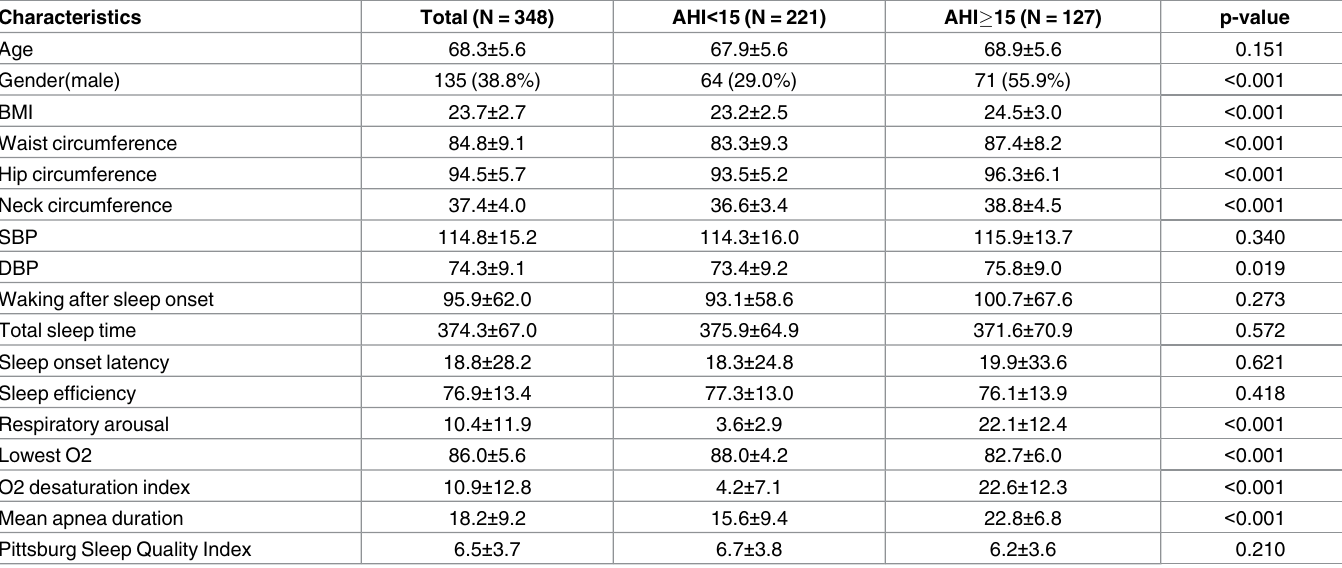
Table 1. Demographic and sleep characteristics of study subjects.